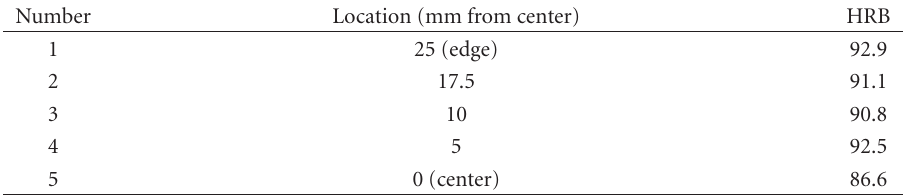
Table 2 . 1 . Hardness values at di ff erent radii for work material